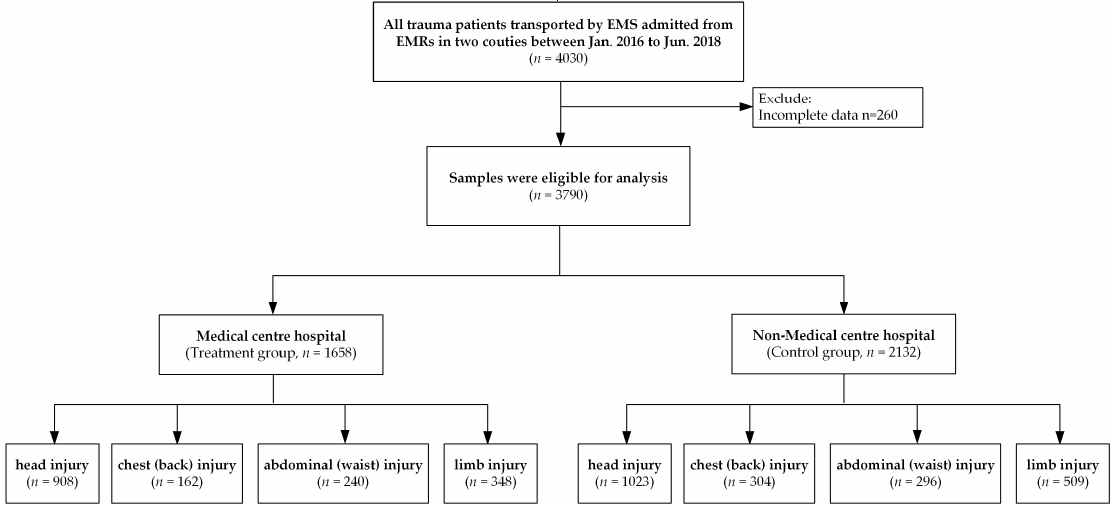
Figure 2. Study design and flow chart of the observations selection and the classification of those observations for propensity score matching.